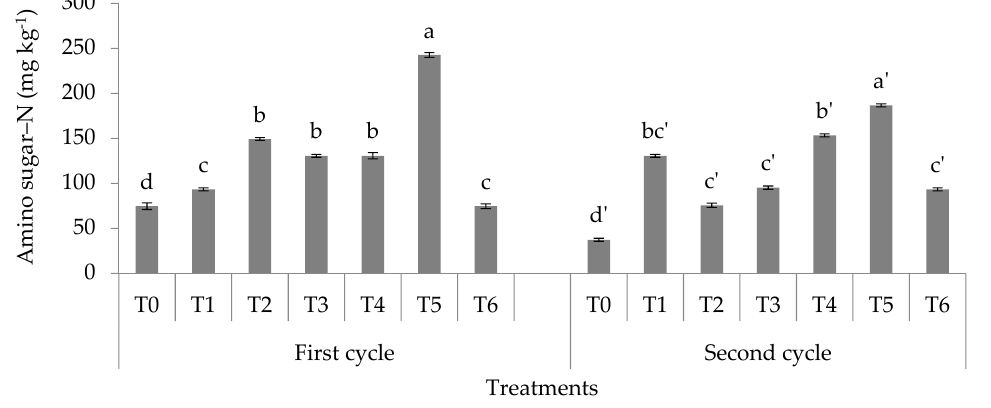
Figure 5. Effects of treatments on soil amino sugar. Means with the same letter above the bars within a crop cycle are not significantly different at p ≤ 0.05. Bars represent the mean values ± standard error . Irrespective of the maize crop e (first or second), higher content of soil amino acid–N resulted for the different treatment combinations consisting of chemical fertilizers, CZ, rice straw compost or paddy husk compost (T2, T3, T4, T5, and T6) at harvest in comparison to the soil alone (T0) and recommended chemical fertilizer application treatment (T1, Figure 6). However, the soil amino acid– N was seemingly lower for the second crop in comparison to the first crop for all the treatments.